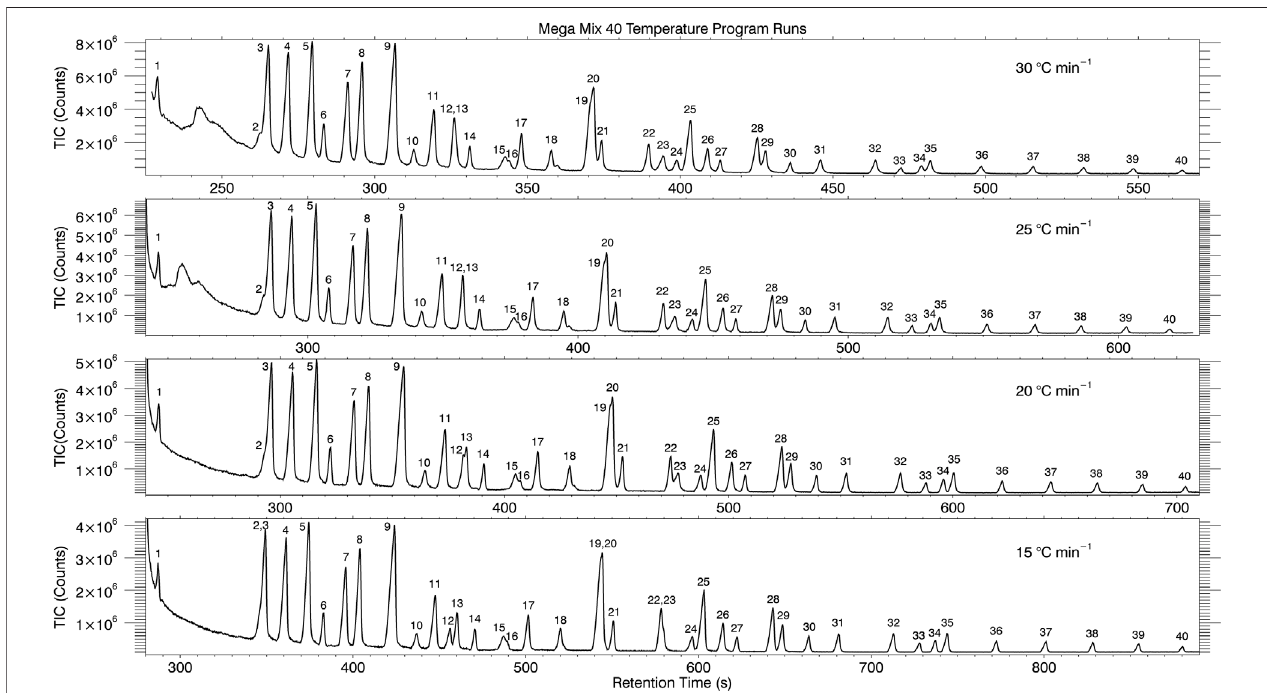
FIGURE 7 | Oven temperature ramp programs from 30 ° C min − 1 – 15 ° C min − 1 in 5 ° C min − 1 intervals attempting to optimize resolving power (separation of all components of Mega Mix